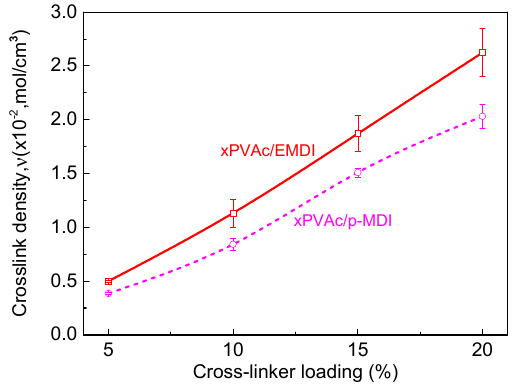
Figure 3. Crosslink density of EPI films at 80% RH with respect to crosslinker loading.